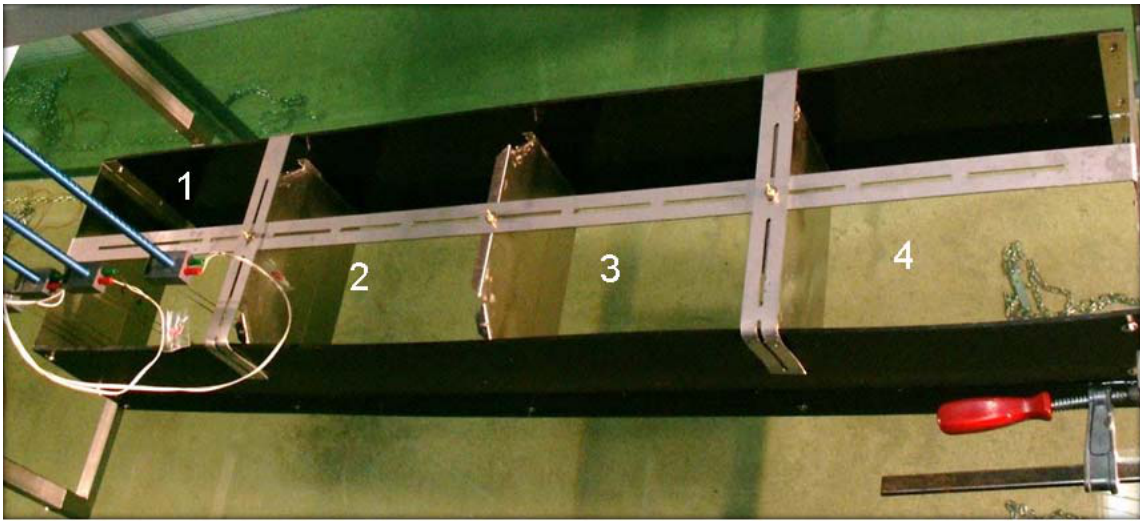
Figure 7. The open model setup: WGs in the 1st of the four